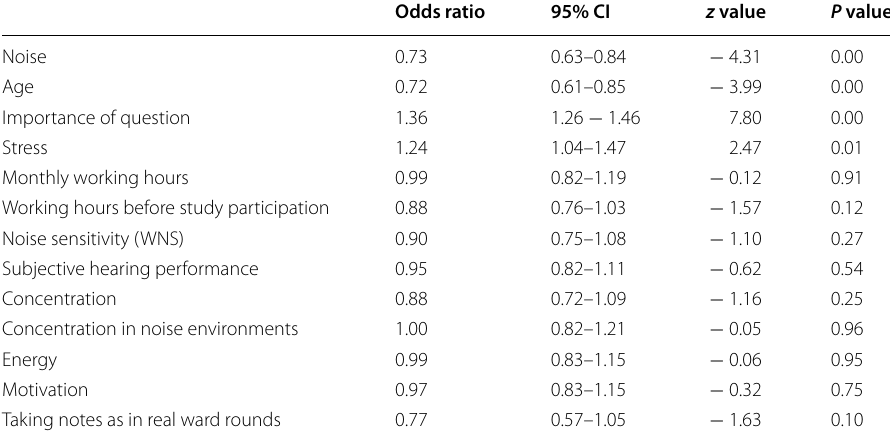
Table 3 Complete performance estimate‑based influencing